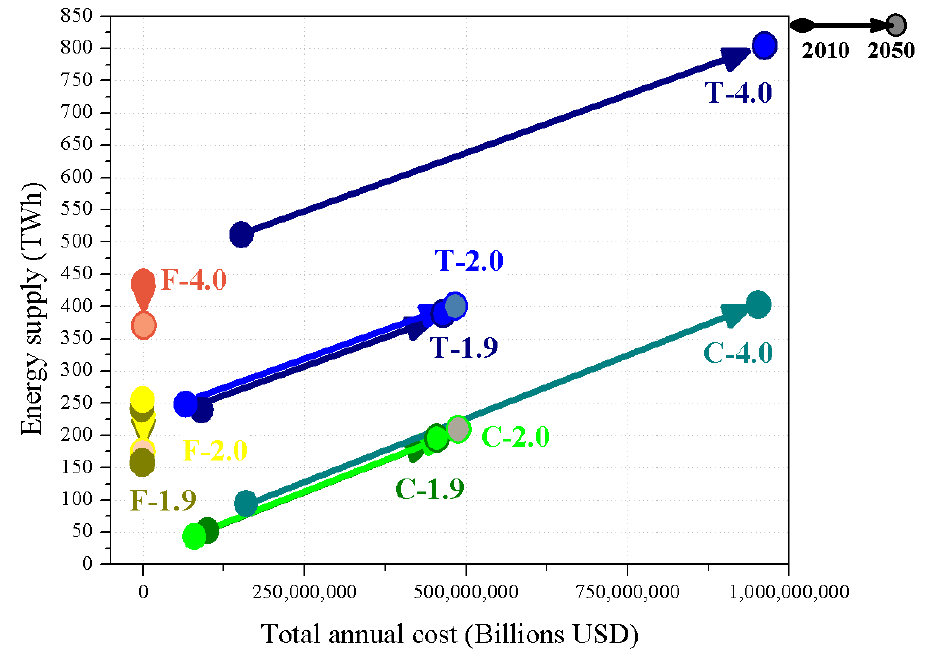
Figure 14. Schematic optimized power plants generation centrals number minimizing total annual cost (TAC) of electricity generation for the CVF population model [19] and three electricity demand